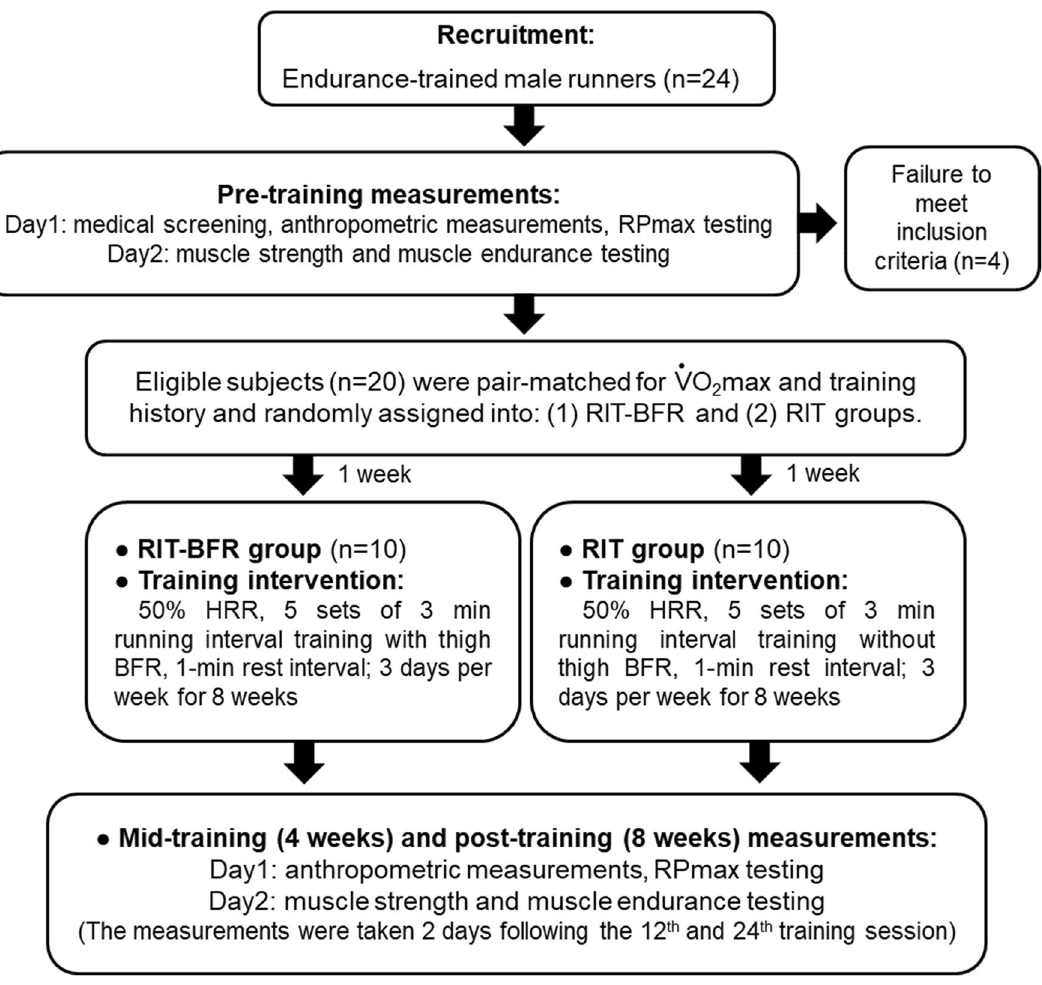
Figure 1. Overview of research design. RIT-BFR: running interval training combined with blood flow restriction group; RIT: running interval training only group; anthropometric measurements: height, body mass and resting systolic blood pressure; RPmax: maximal running